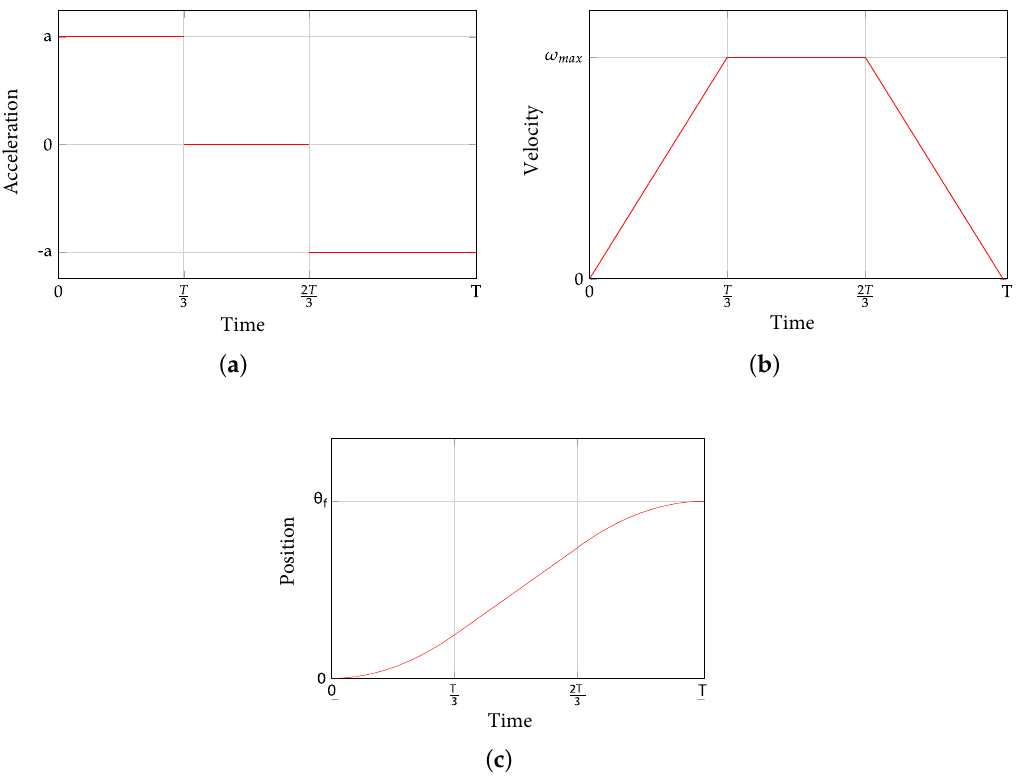
Figure 2. Curves obtained for the trapezoidal profile: ( a ) Acceleration, ( b ) Velocity, ( c )